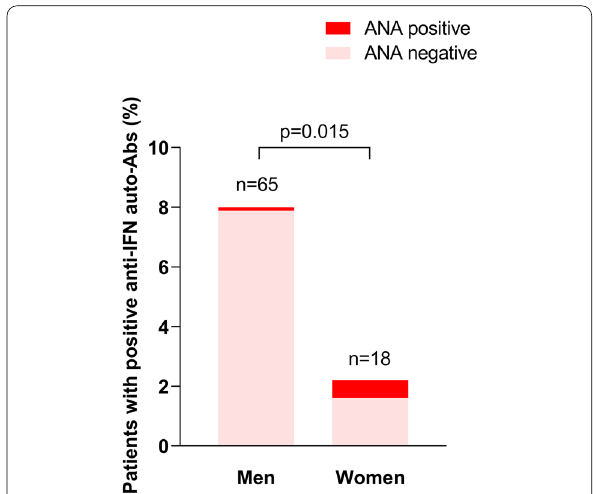
Fig. 3 Positivity of anti‑nuclear antibodies (ANA) according to gender in patients with positive anti‑interferon (IFN) auto‑antibodies (auto‑Abs). ANA were screened in the serum of 812/925 patients of the cohort. ANA‑positive patients are shown in red and ANA negative patients in pink. P value comes from the Fisher exact